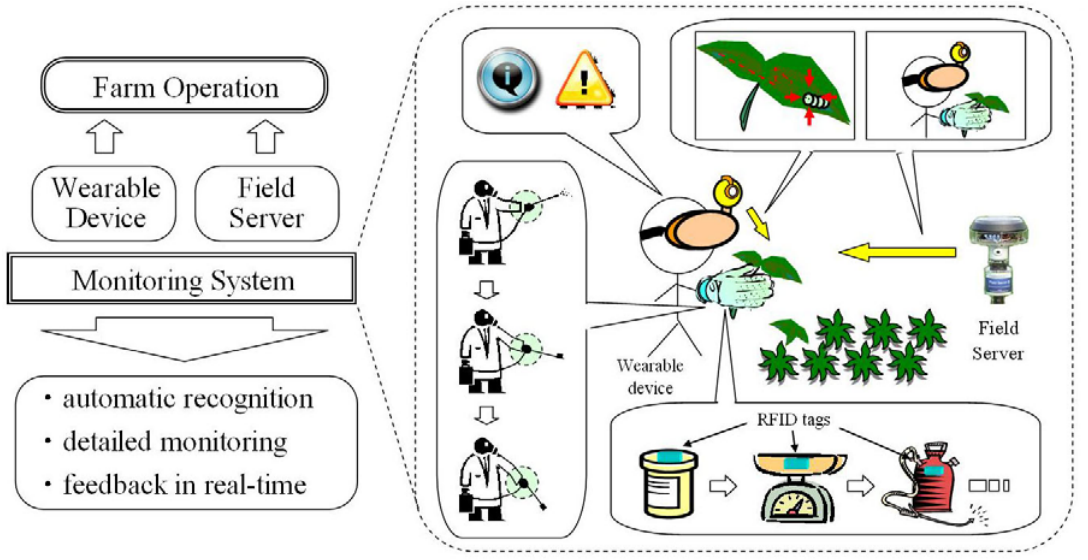
Figure 1. Concept of farm operation monitoring